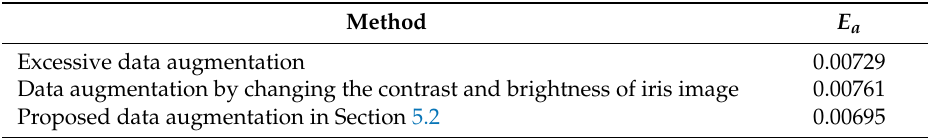
Table 3. Comparative accuracies according to various augmentation